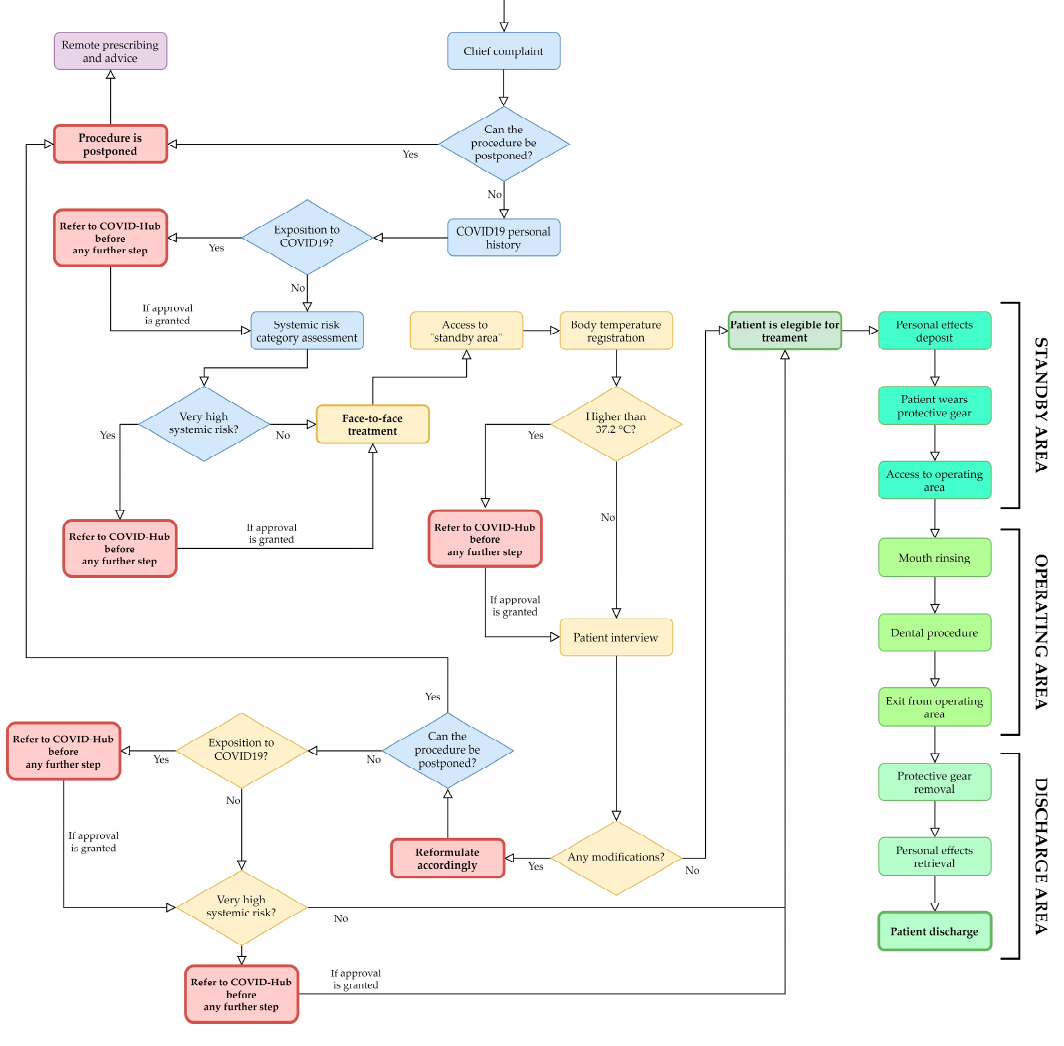
Figure 2. Proposed flow-chart for patient